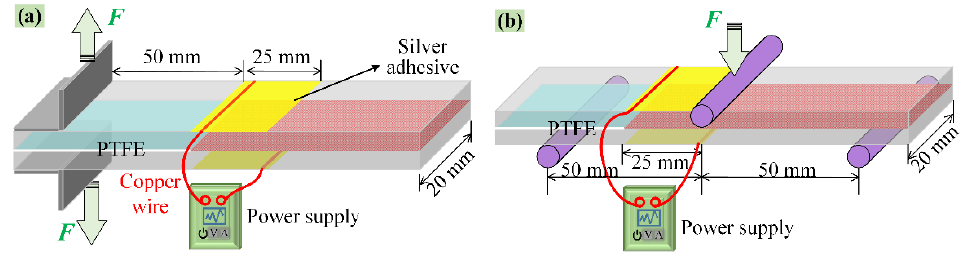
Figure 2. ( a ) DCB specimen and crack healing by electrical heating, ( b ) ENF specimen and crack healing by electrical heating.